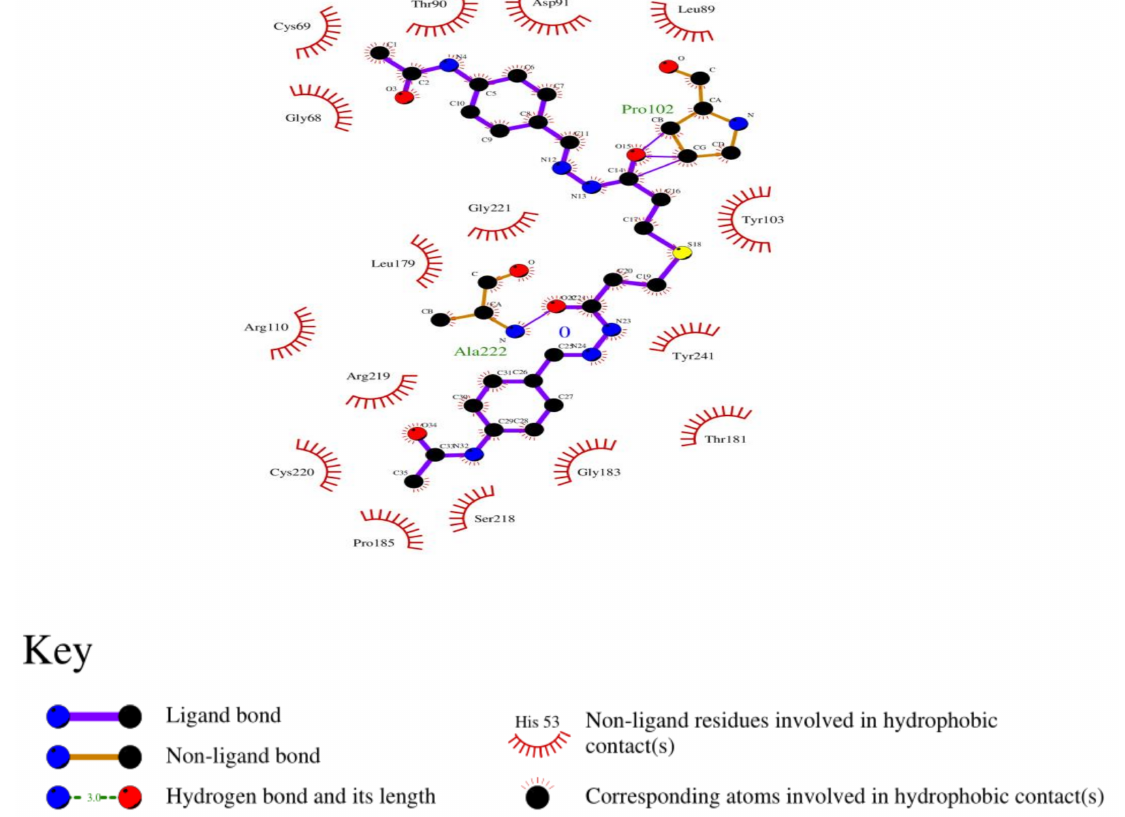
Figure 8. 2D interaction of [(5Z)-5-[(4-ethoxy-3-methoxyphenyl)methylidene]-2,4-dioxo-1,3. thiazolidin-3-yl]ethylazanium and HCV E2